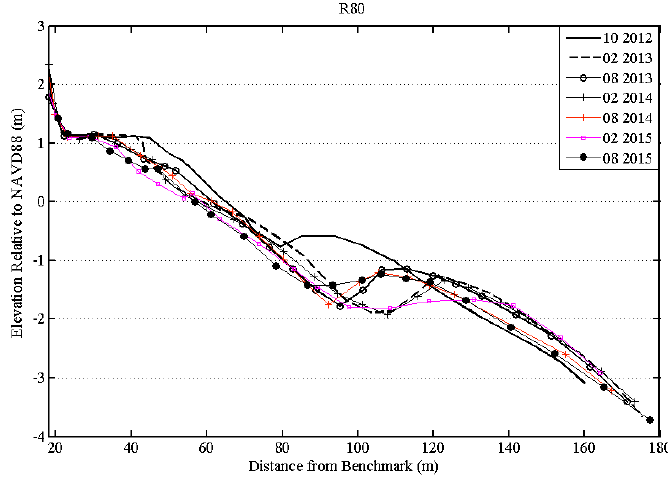
Figure 7. Example profile from Indian Rocks, R80.